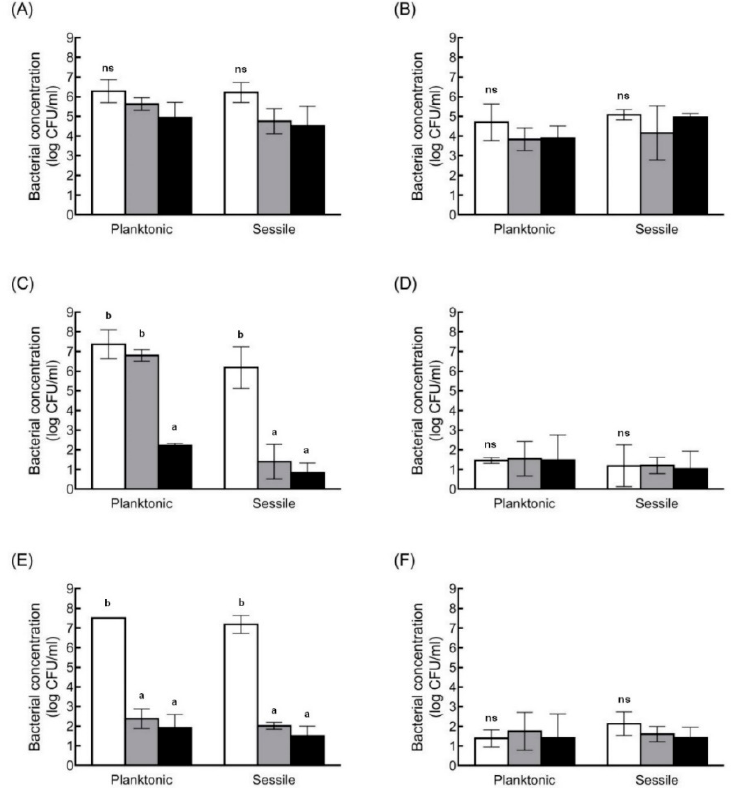
Figure 3. Survival of C. perfringens vegetative cells and spore resistance under oxidative stress. Bacterial concentrations of TYJAM-D-66 ( A , B ), CMM-C-80 ( C , D ), and SDE-B-202 ( E , F ) in vegetative cells ( A , C , E ) and spores ( B , D , F ), after exposure to atmospheric oxygen for 0 h ( (cid:3) ), 18 h ( (cid:110) ), and 36 h ( (cid:110) ). Different lowercase alphabets indicate significant differences between groups at same conditions ( p <